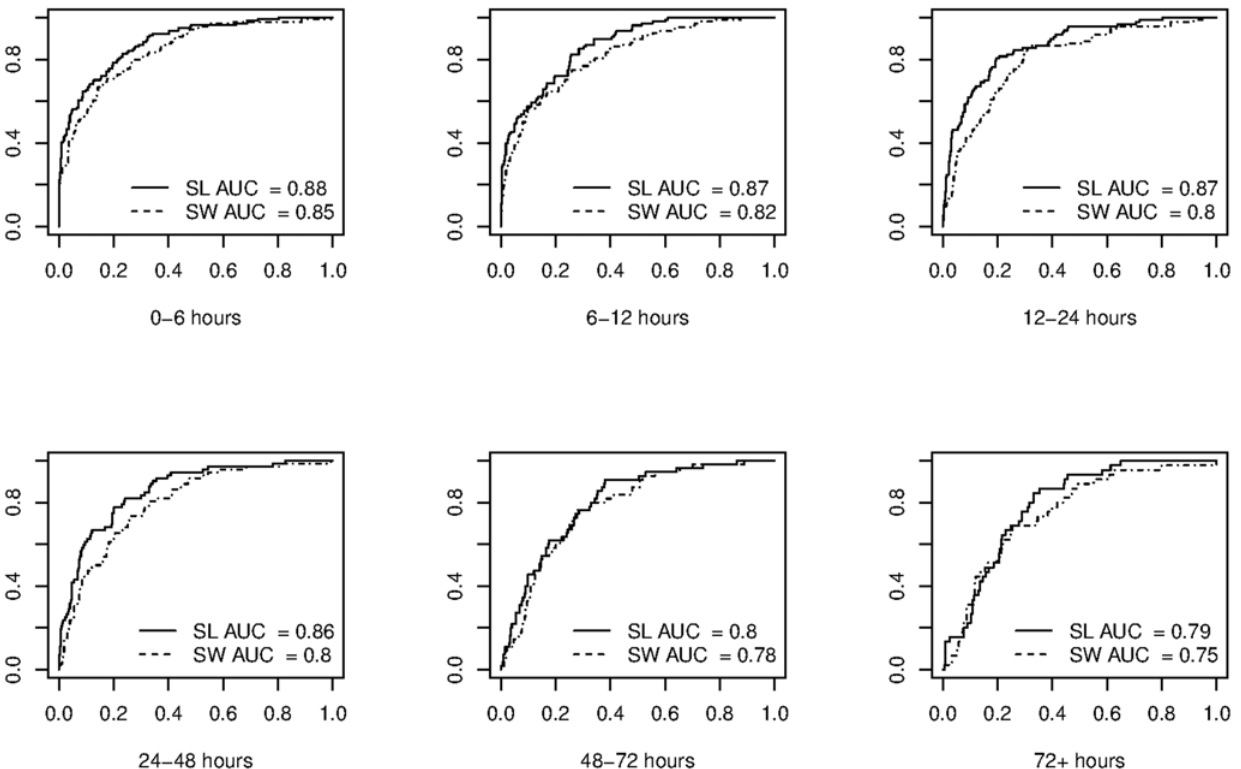
Fig 2. ROC curves of cross-validated prediction for the super learner (SL) and the logistic step-wise regression (SW), for different time